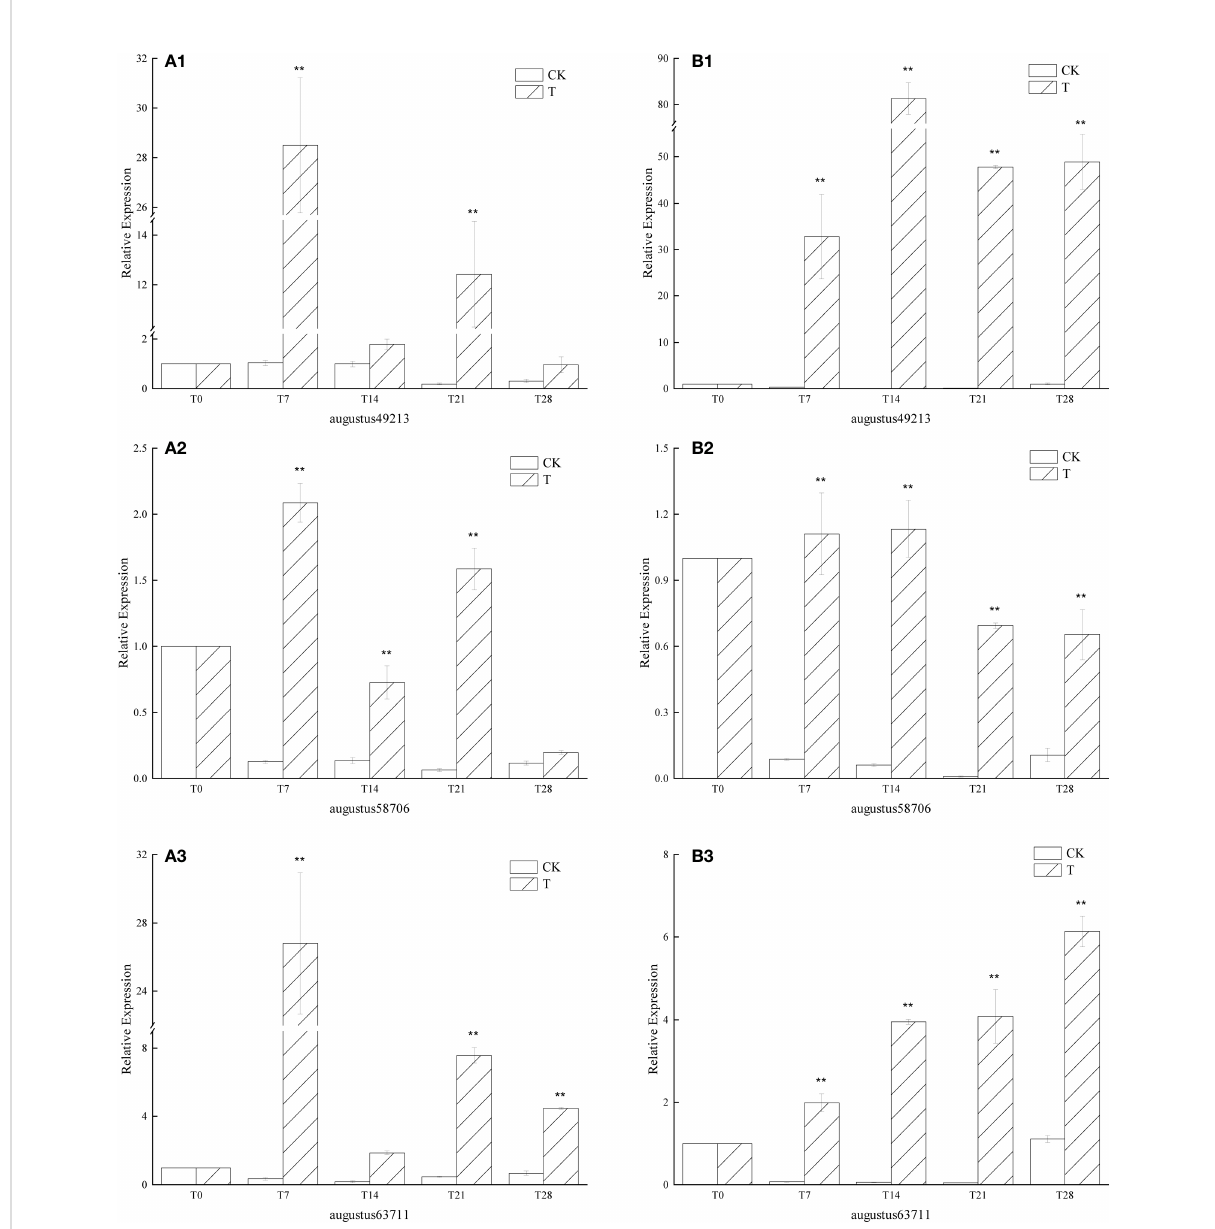
FIGURE 6 Relative expression of similar genes augustus49213, augustus58706 and augustus63711 of GA in the leaves of plants with different treatments of L. chinense var. rubrum. ‘ (A) ’ represents the relative expression of GA similar genes in leaves of ‘ Xiangnong Xiangyun ’ under different treatments. ‘ (B) ’ represents the relative expression of GA similar genes in leaves of ‘ Hei Zhenzhu ’ under different treatments. ‘ T ’ represents the low- temperature treatment group, ‘ CK ’ represents the blank control group treated at 25°C. ** extremely signi fi cant